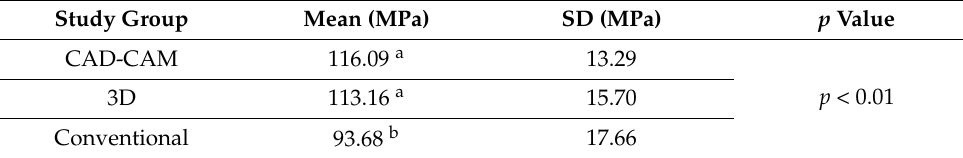
Table 2. Comparison of flexural strength among the study groups (CC, 3D, and CV). Study Group Mean (MPa) SD (MPa) p Value CAD-CAM 116.09 a 15.70 Conventional 93.68 b 17.66 Dissimilar superscript small alphabets denote statistical significance ( p <